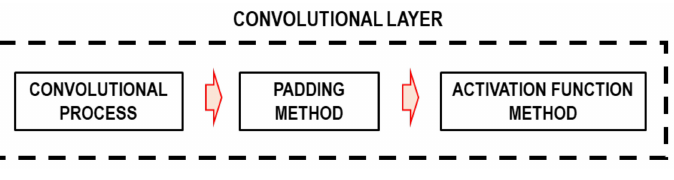
Figure 16. Convolutional layer.